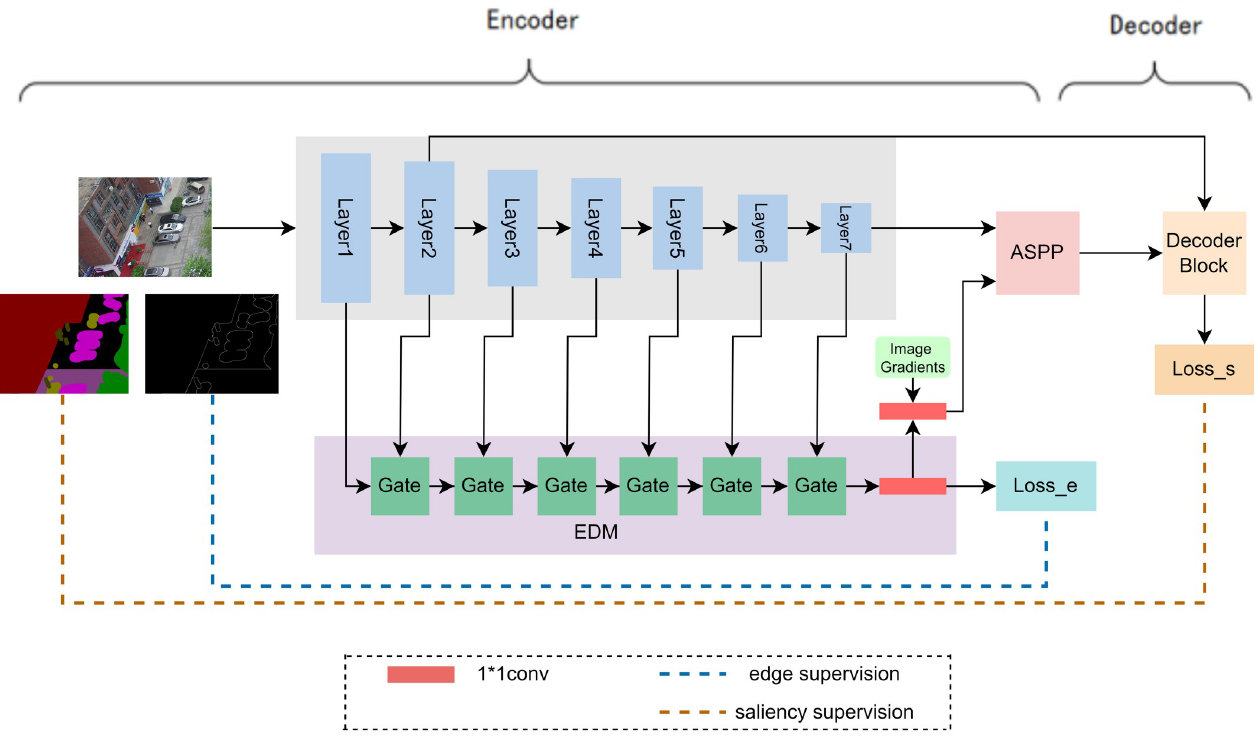
Fig 1. EMNet structure.